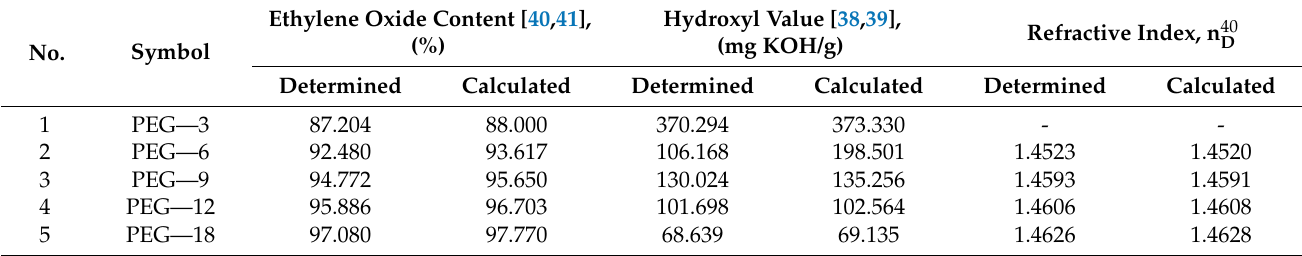
Table 8. The main chemical and physico-chemical characteristics of homogeneous polyethylene glycols, (EO) n , n = 3, 6, 9, 12, 18.